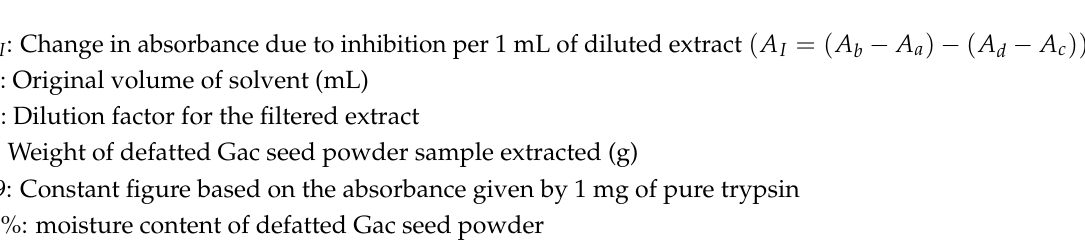
19: Constant figure based on the absorbance given by 1 mg of pure trypsin m %: moisture content of defatted Gac seed